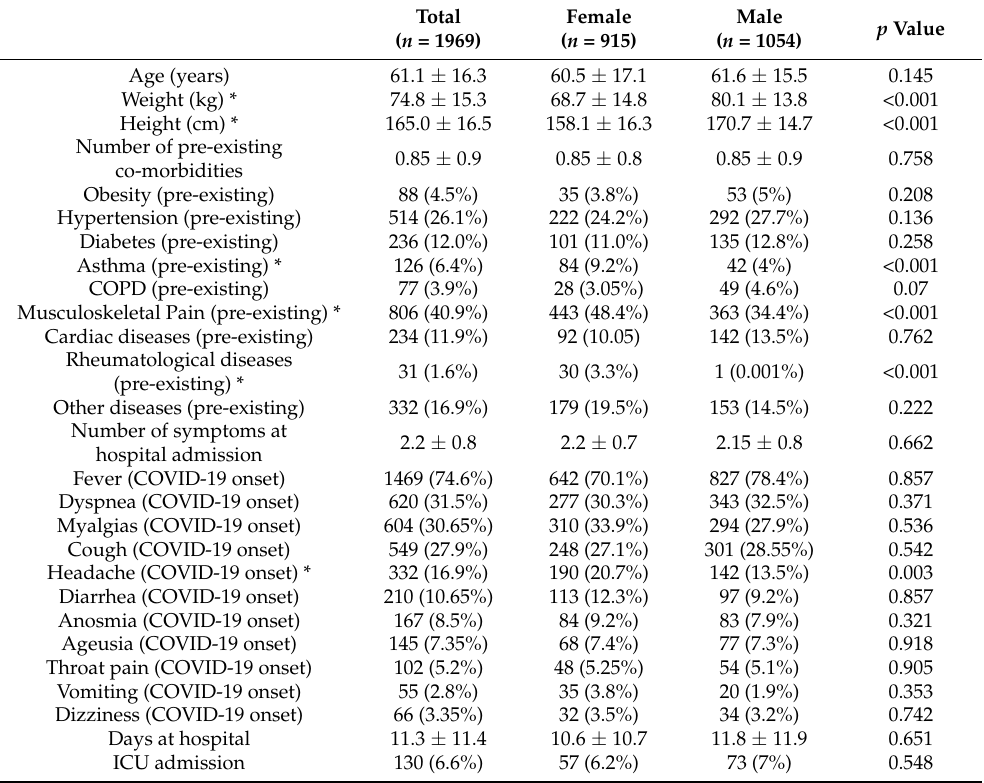
Table 1. Clinical and hospitalization data according to sex.